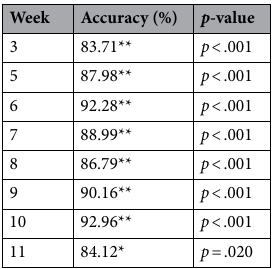
Table 1. Mean SVM classification accuracy at each age after 1,000 bootstrapped runs, classifying α-synuclein rats and control rats into their correct class, when all electrodes were included in the analysis. ** p < 0.001, * p <